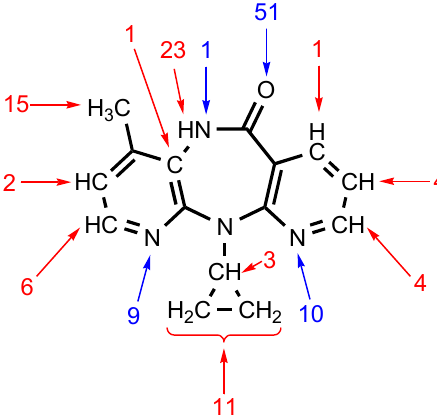
Figure 1. Statistical analysis results for the crystal structures containing nevirapine. Blue arrows highlight atoms that act as nucleophilic components of noncovalent interactions, while those acting as electrophilic components are marked by red arrows. Only the interactions of nondisordered fragments were taken into account, while π -stacking interactions were not.